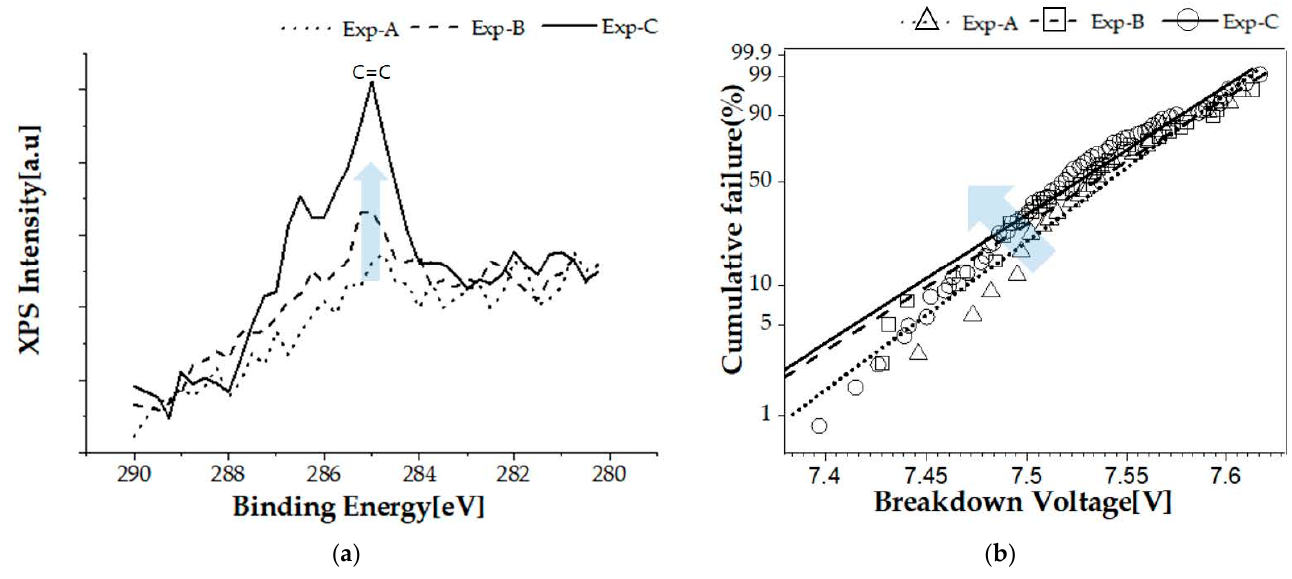
Table 1. Weibull parameters for breakdown voltage in Figure 4b.